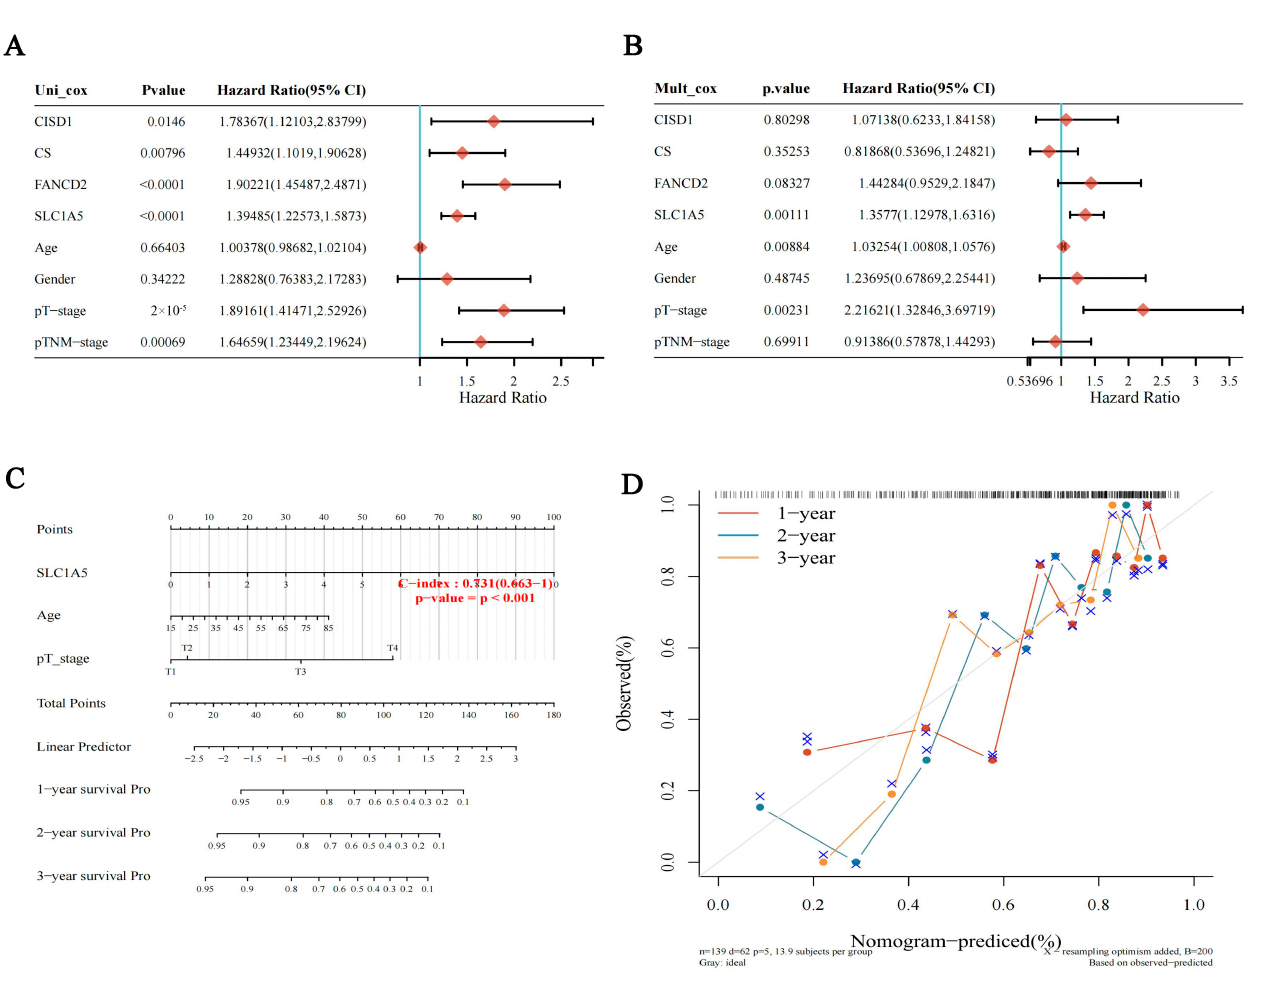
Figure 3. Analysis of prognostic value for FANCD2, CS, SLC1A5 and CISD1 in HBV-related HCC. The p value, risk coefficient (HR) and confidence interval were analyzed by univariate ( A ) and mul ‐ tivariate ( B ) Cox regression. ( C ) Nomogram can predict the 1 ‐ yea, 2 ‐ year and 3 ‐ year overall survival